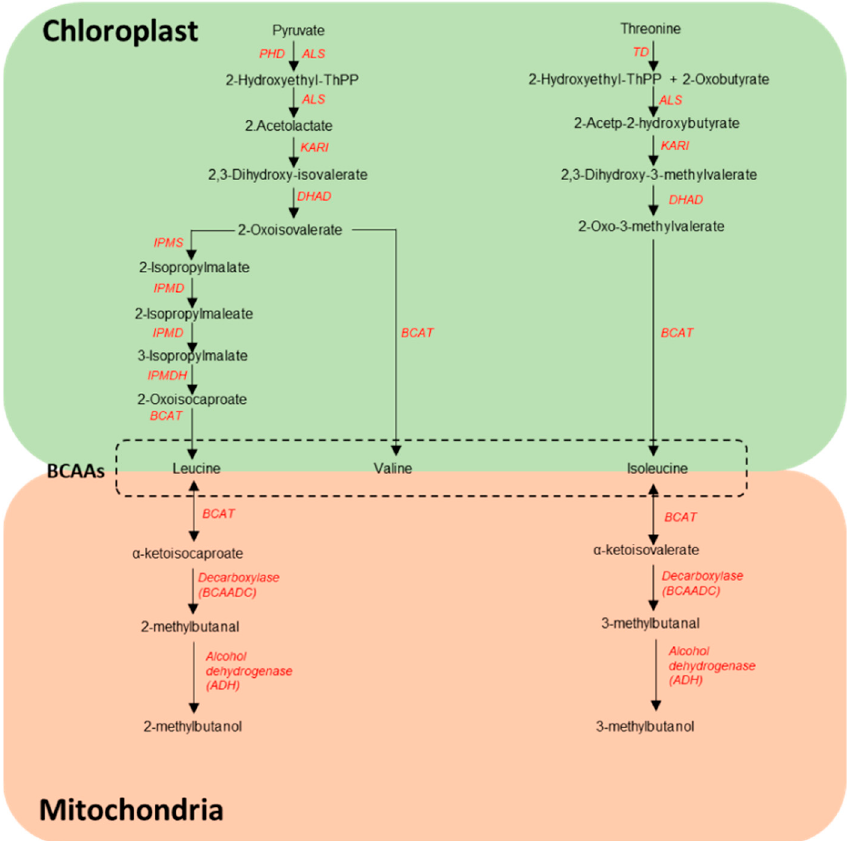
Figure 3. Overview of the proposed BCAA VOCs pathway, adapted from [94,130]. TD: threonine dehydratase; ALS: acetolactate synthase; KARI: ketol-acid reductoisomerase; DHAD: dihydroxy-acid dehydratase; BCAT: branched-chain aminotransferase; IPMS: 2-isopropylmalate synthase; IPMD: 3-isopropylmalate dehydratase; IPMDH: 3-isopropylmalate dehydrogenase; PDH: pyruvate dehydrogenase.